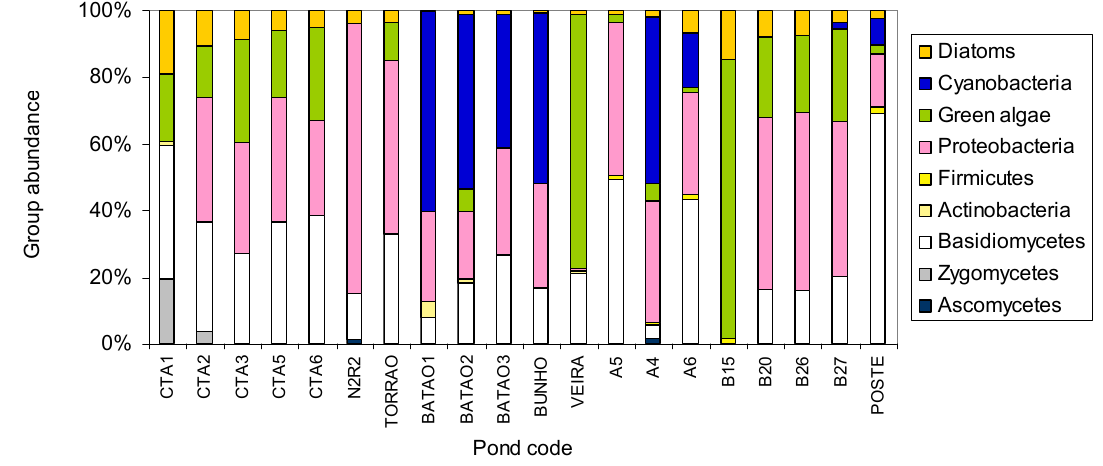
Figure 4. Relative abundance of autotrophic (diatoms, cyanobacteria and green algae) and heterotrophic (proteobacteria, firmicutes, actinobacteria, basidiomycetes, zygomycetes and ascomycetes) biomass in temporary ponds in southwest